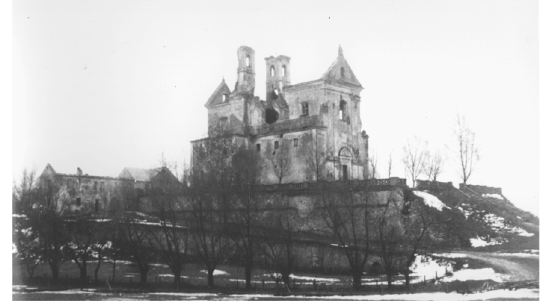
Fig. 1. Aerial view of the Monastery with the Church, Royal House and Chancellor Chapel at the front and hermitages at the back (photo by W. Wolkow, 2005)